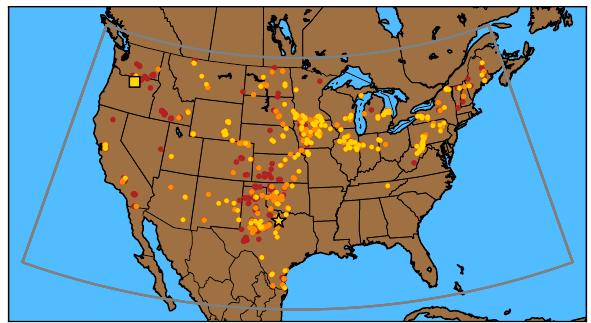
Figure 1. Wind farm locations in the CONUS: nonfiltered 607 sites in dark red, R 2 -filtered 349 sites in orange, and r -filtered 195 sites in yellow. The yellow square represents the Oregon site and the yel- low star indicates the Texas site (Table 2). The grey box illustrates the boundary of the CONUS used in this